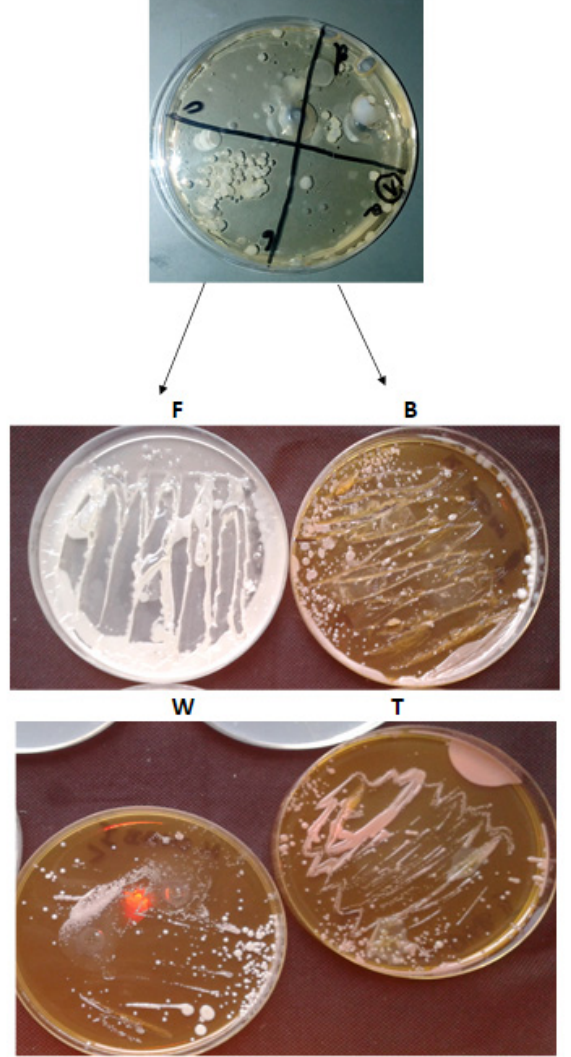
Figure 1. Examples of bacteria on growth media after collecting the bacterial inoculum from patients marked as F, B, W, T (see Section 2.2), relating to each type of diet. Grown fungal colonies (including yeasts) indicate a serious oral cavity infection and insufficient hygiene, therefore only grown bacterial colonies were used for sequencing, in line with the assumptions of the study.